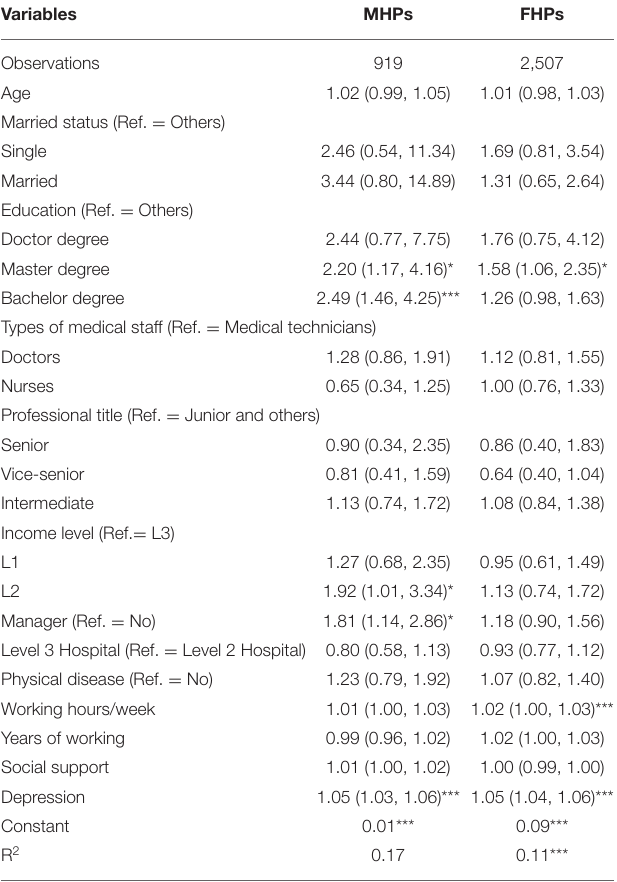
TABLE 4 | Logistic regressions for the factors associated with workplace violence, among MHPs and FHPs [OR (95% CI)].